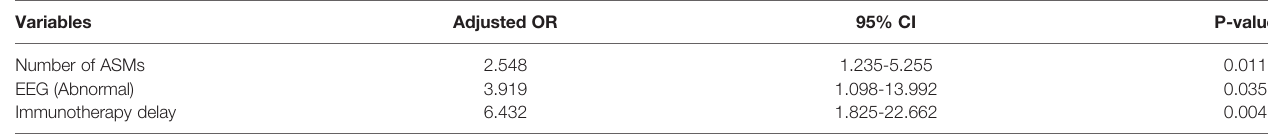
TABLE 7 | Multivariable logistic regression analysis of factors independently associated with the development of epilepsy in total AE patients. Variables Adjusted OR 95% CI P-value Number of